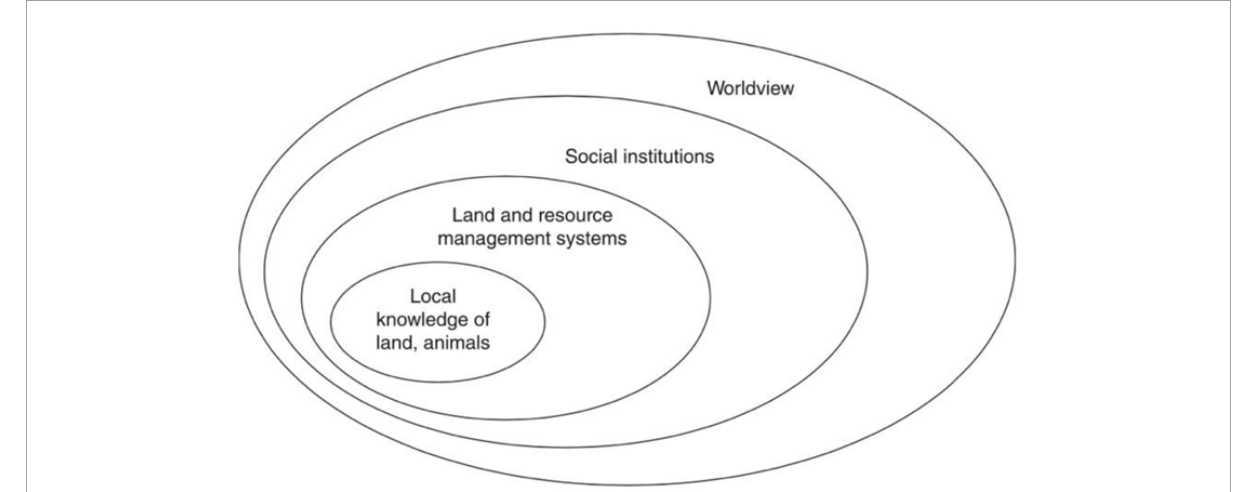
FIGURE2 Levels of analysis in traditional knowledge and management systems. Source: (Berkes, 2012, 17).